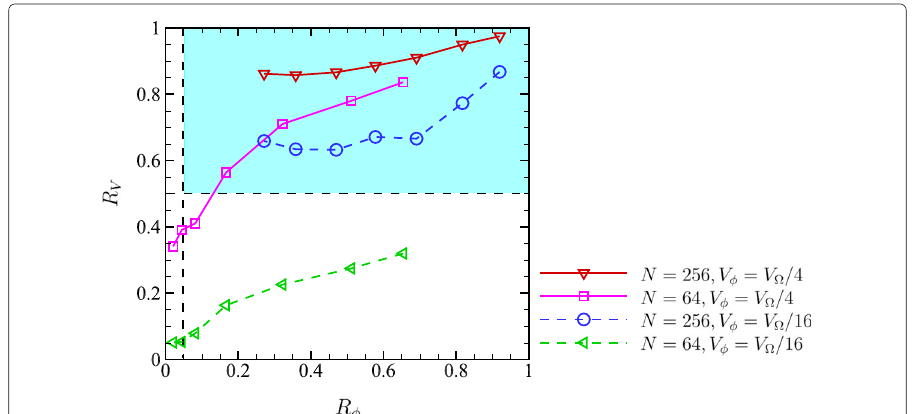
Fig. 6 Correlation of the data points of R V and R φ in the TG flow for Re = 400. The symbols on the same curve from right to left are obtained at t TG = 4.0,4.5,5.0,5.5,6.0,6.5,7.0. The region satisfying the tracking criteria in Eq. (17) is shaded in light blue